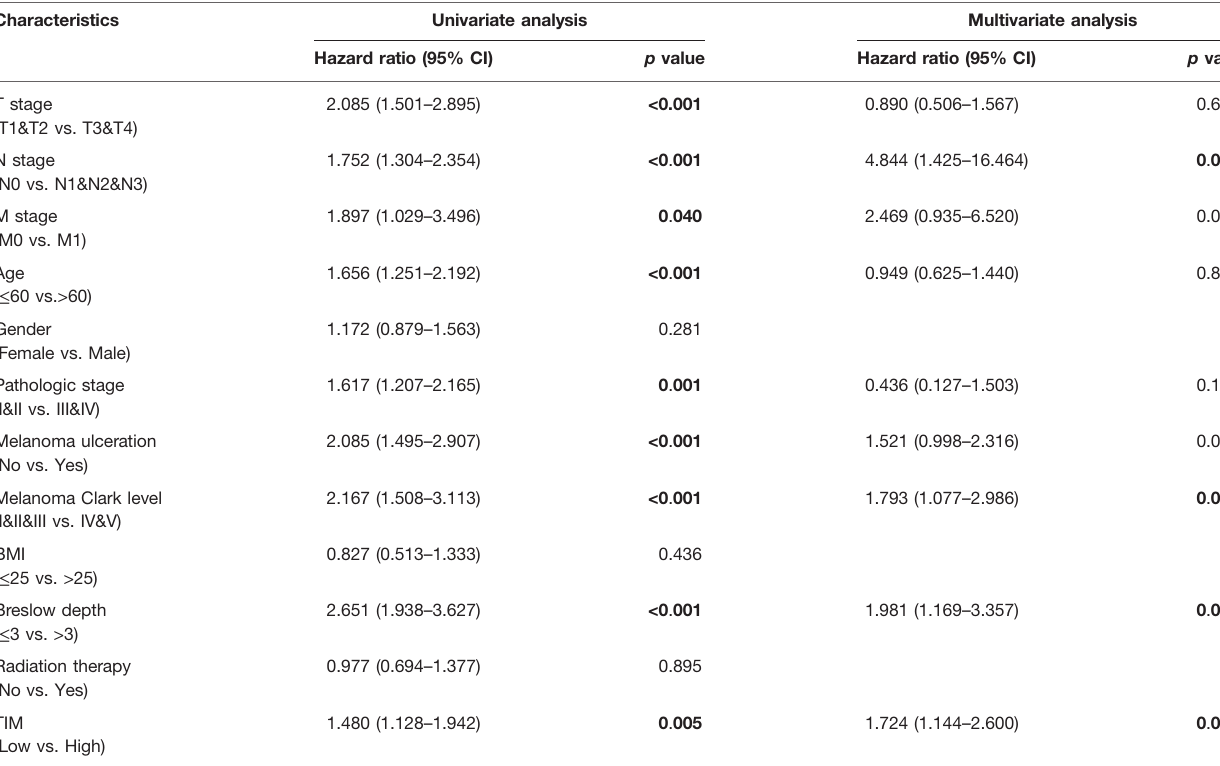
TABLE 3 | Univariate and multivariate Cox proportional hazards analysis of TIM expression and OS for SKCM patients.